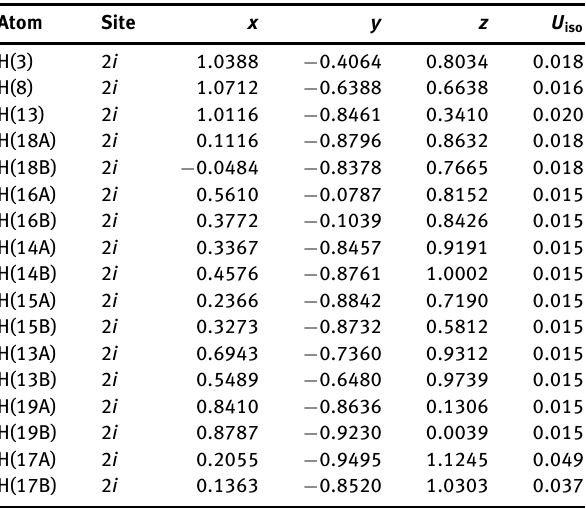
Table 2: Fractional atomic coordinates and isotropic or equivalent isotropic displacement parameters (Å 2